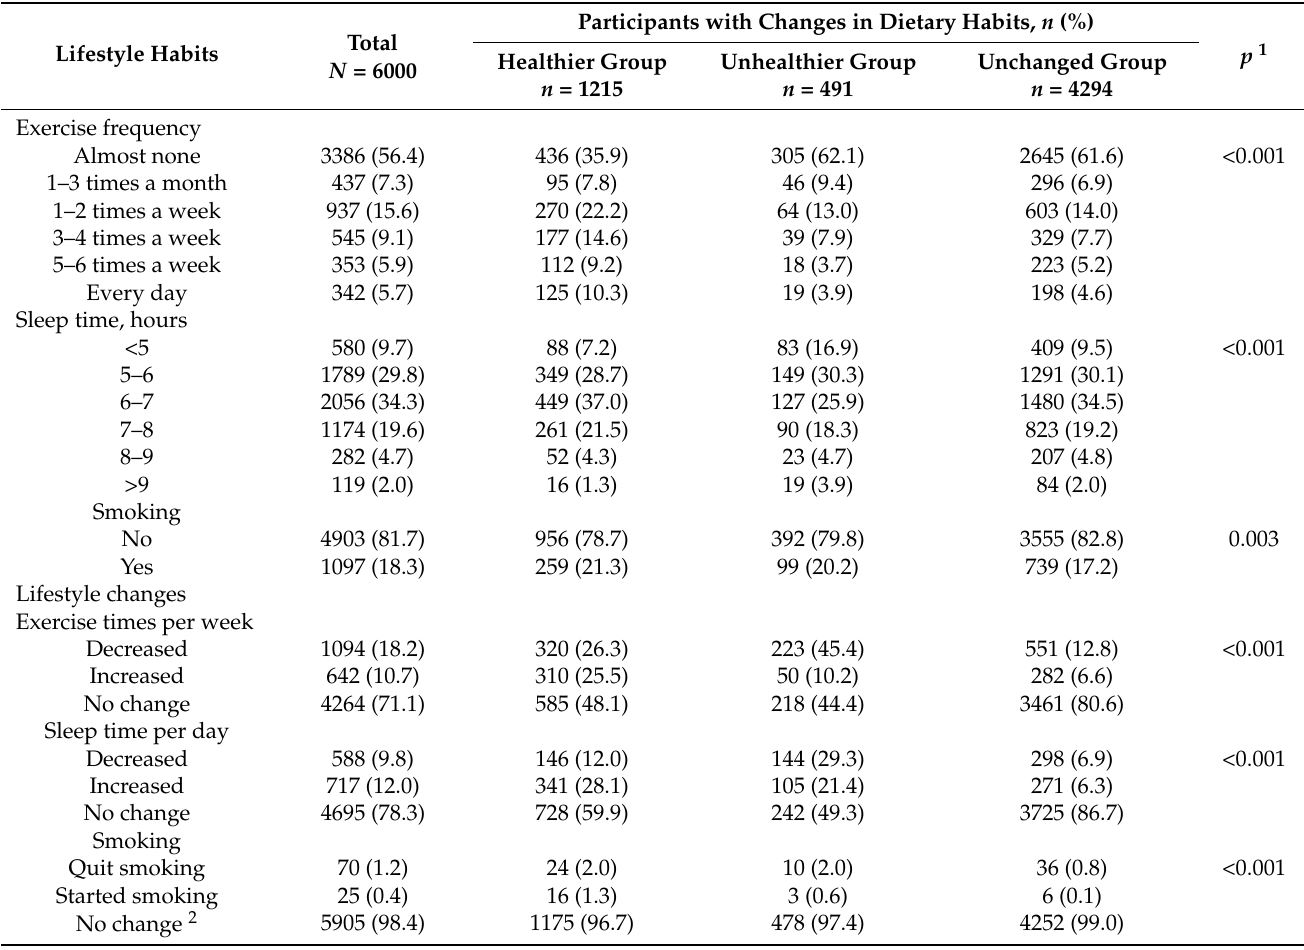
Table 4. Comparison of lifestyle habits among the healthier, unhealthier, and unchanged